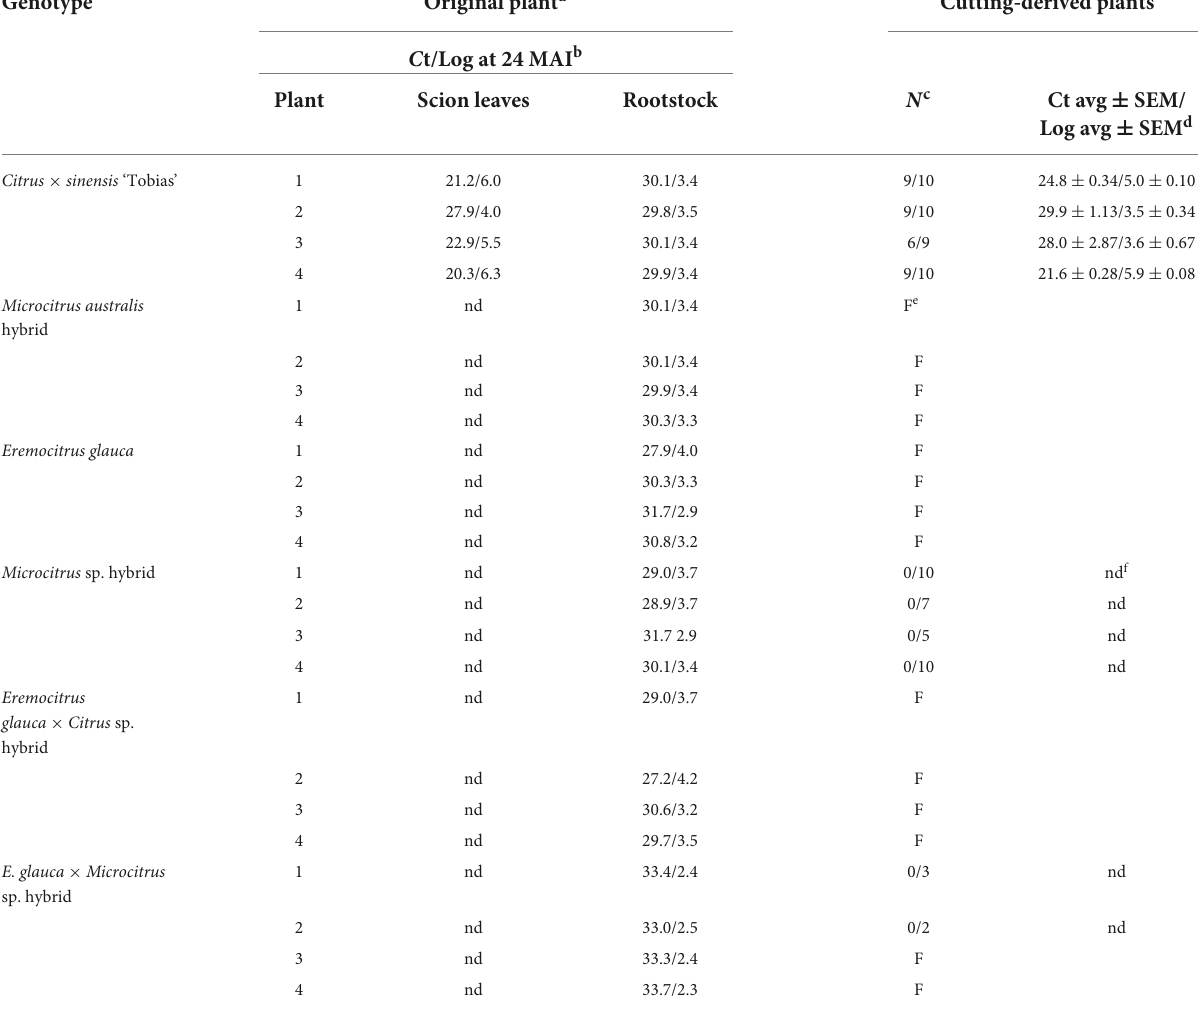
TABLE 6 ‘ Candidatus Liberibacter asiaticus’ (Las) infection in leaves of cutting-derived plantlets obtained from Oceanian citrus genotypes and ‘Tobias’ sweet orange control, all grafted onto Las-infected ‘Rangpur’ lime rootstocks, 2 years before and 10 months after cutting propagation.